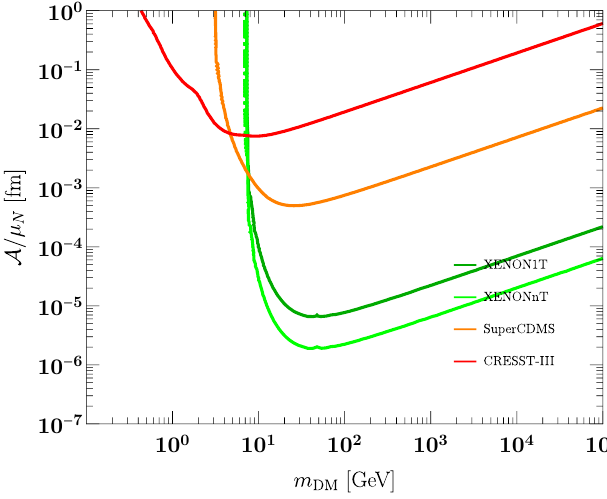
Figure 8. Upper limit on the anapole moment of a Majorana spin 1/2 fermion as dark matter candidate from the XENON1T, SuperCDMS and CRESST-III data, and projected sensitivity for